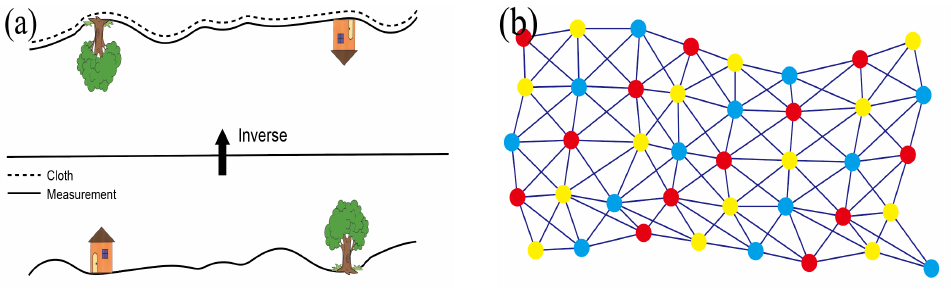
Figure 4. Working principle and mesh distribution of CSF : ( a ) is the working principle of CSF ; ( b ) is the cloth grid made up of interrelated